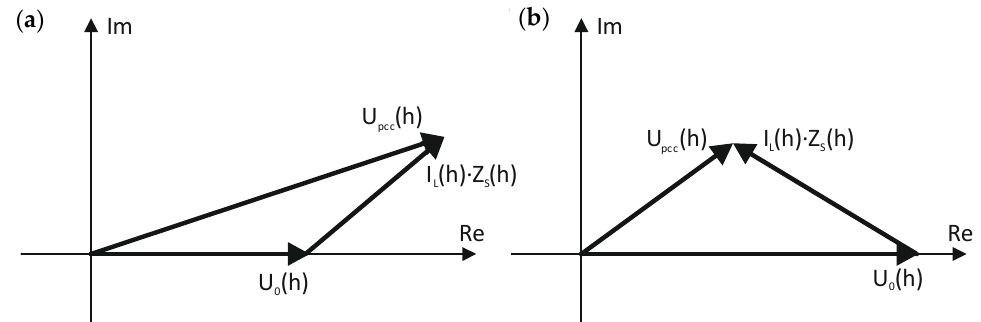
Figure 2. Effect of load or generation connection on the magnitude of harmonic voltage h in the PCC: ( a ) increase, ( b ) decrease [22].